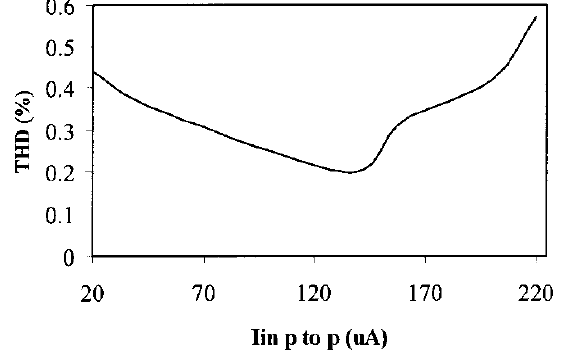
FIGURE 8 THD results for APS-II with 100kHz